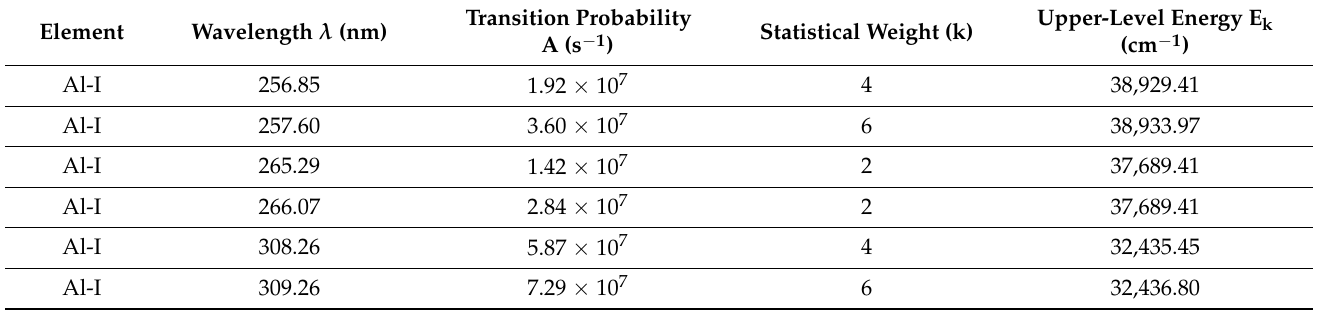
Table 1. Spectroscopic parameters of Al-I lines used to draw the Boltzmann